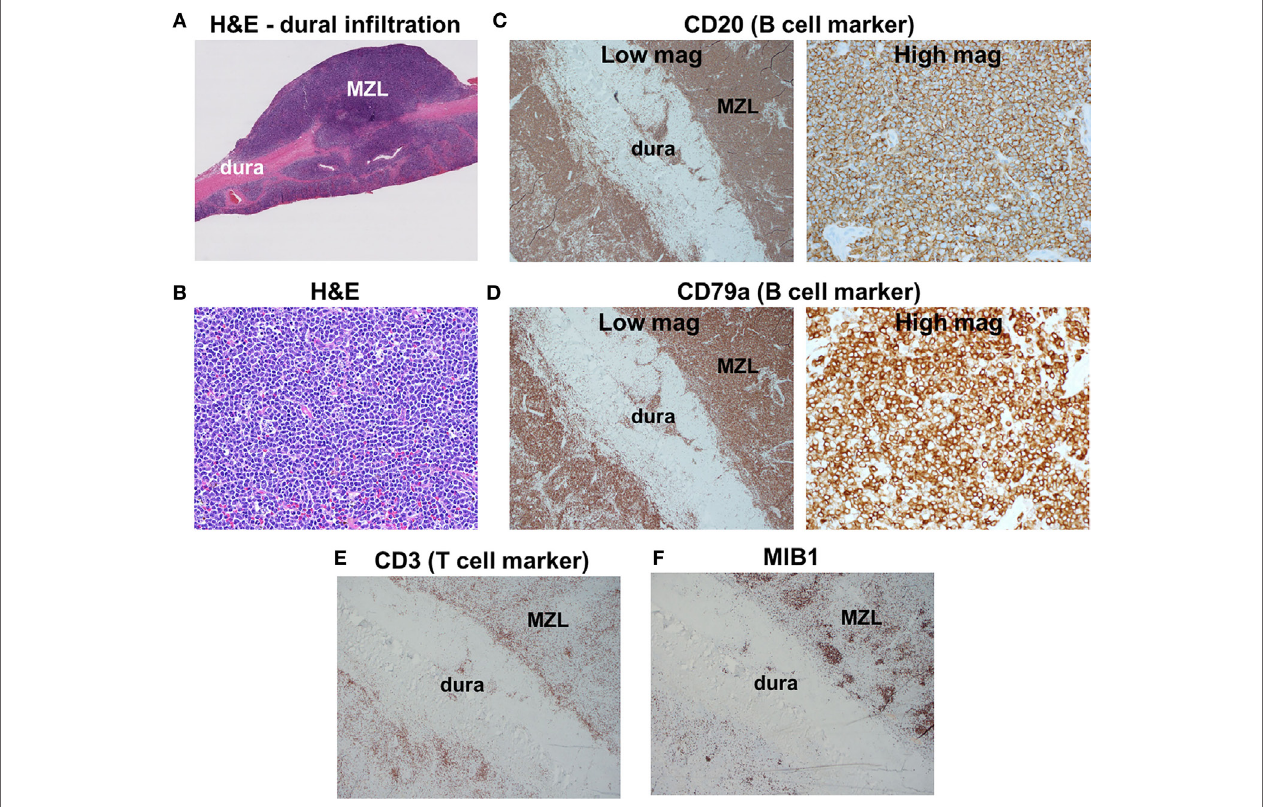
FiGURe 2 | Histologic findings. (A) Low-magnification H&E staining reveals infiltration of dura by marginal zone lymphoma (MZL) tumor cells. (B) High-magnification H&E photomicrograph of the neoplasm indicates densely packed small cells. (C,D) Tumor cells are positive for the B cell markers CD20 and CD79a. (e) Scattered reactive CD3 + T cells are found within the neoplasm. (F) MIB1 is focally elevated in germinal centers within the